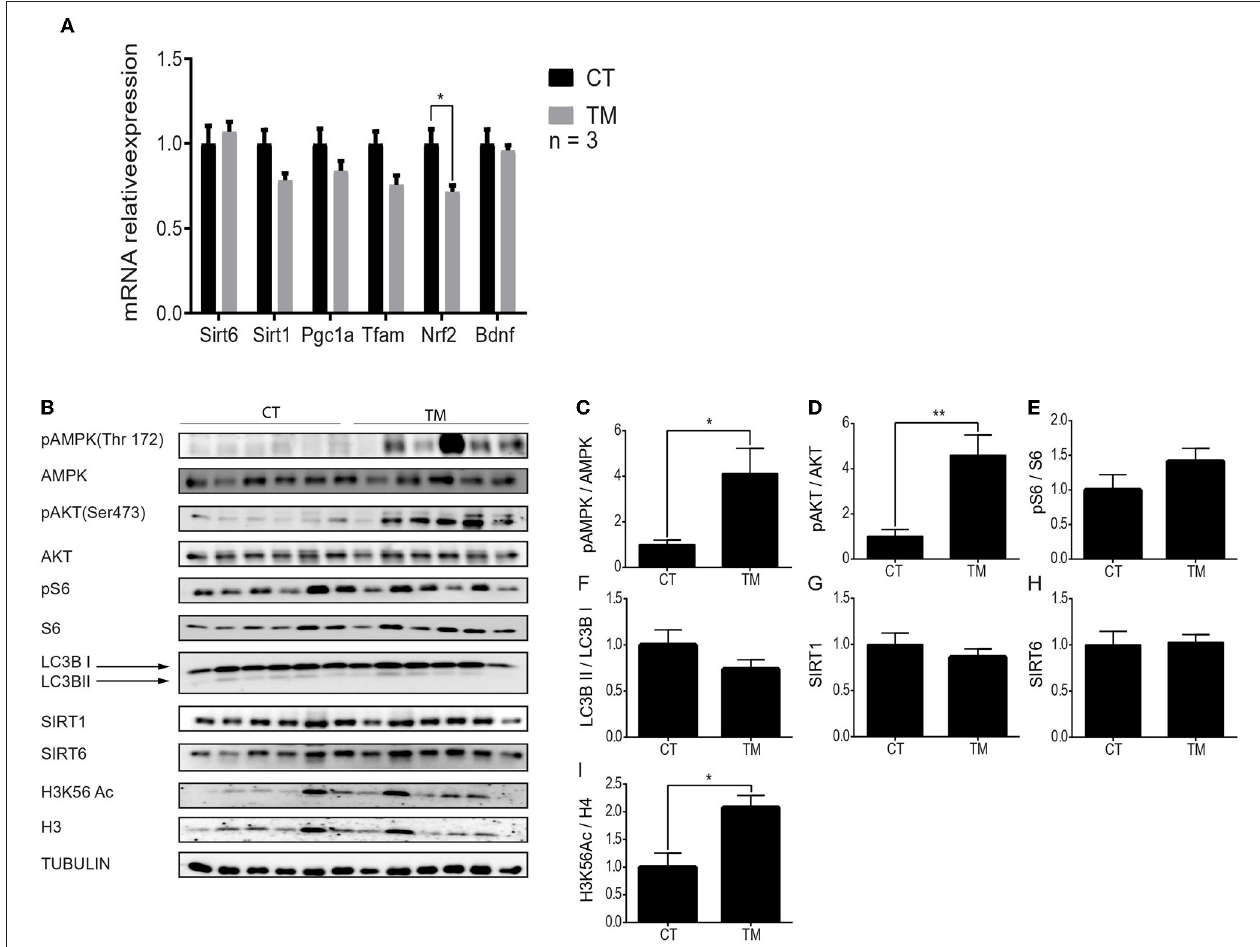
FIGURE 3 | Unique hippocampal metabolic signaling pathway activation under forced exercise. (A) Relative gene expression levels of Sirt6 , Sirt1 , Pgc1 α , Tfam , Nrf2 , and Bdnf at rest (CT) or under short-term forced (TM) exercise. (B) Western blot analysis of p-AMPK, AMPK, pAKT, AKT, pS6, S6, LC3B, SIRT1, SIRT6, and H3K56Ac, in the hippocampi of young (4–6 months) WT male mice at rest (CT) or under long-term forced exercise (TM). Tubulin served as the loading control. (C) Expression ratios: Phosphorylated AMPK to unphosphorylated AMPK, (D) phosphorylated AKT to unphosphorylated AKT, (E) phosphorylated S6 to unphosphorylated S6, (F) LC3B II protein expression normalized to LC3B I protein expression, (G) SIRT1 and (H) SIRT6 protein expression normalized to tubulin, and (I) H3K56Ac normalized to H3 in young (4–6 months) WT male mice in the hippocampus. The values shown are mean ± s.e.m., * p < 0.05 (two-way ANOVA, followed by Bonferroni post hoc test in (A) , two-tailed t -test for (C–I) ; in (A) , n = 3 for CT and TM; In (B–I) n = 6 for CT and